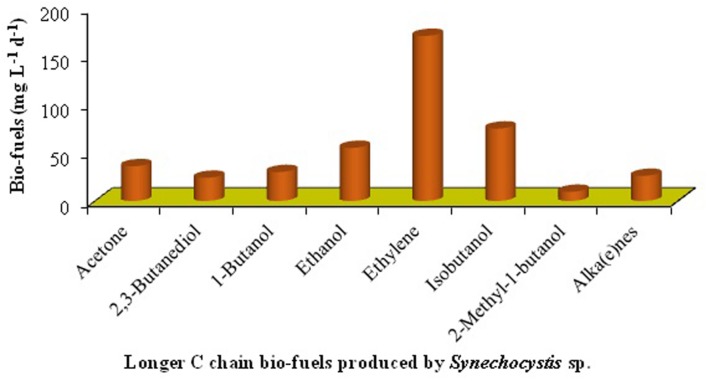
Production of bio-fuels from genetically modified cyanobacteria (data has been modified from Machado and Atsumi, 2012; Nozzi et al., 2013).